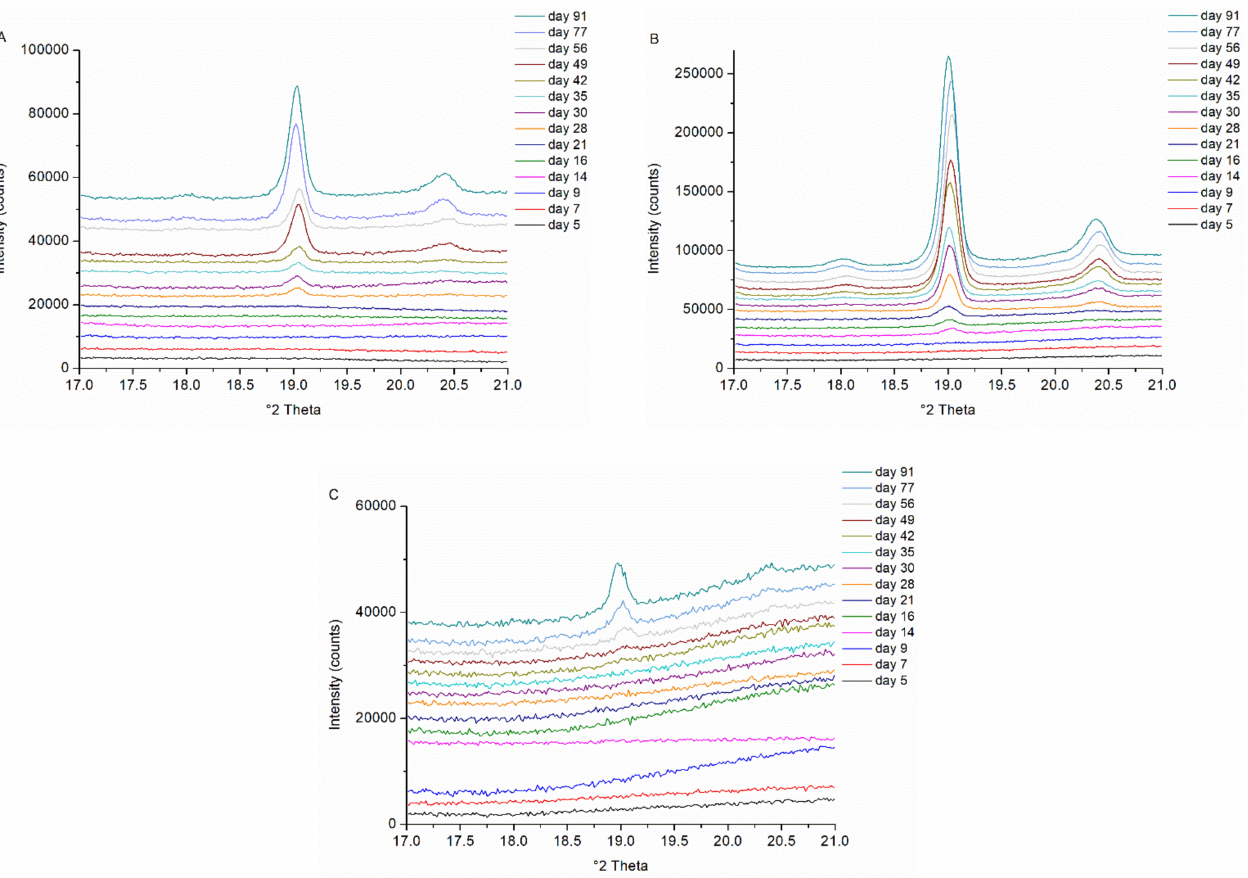
Figure 8. XRPD diffractograms for the various analysis time points (days upon storage) for ( A ) the NAP_40_PVP-VA formulation coated onto pellets (BC 40 milled), ( B ) the spray dried NAP_40_PVP- VA formulation (SD 40) and ( C ) the spray dried NAP_35_PVP-VA system (SD 35), stored at 40 ◦ C/75% RH. Intensities are shown as arbitrary